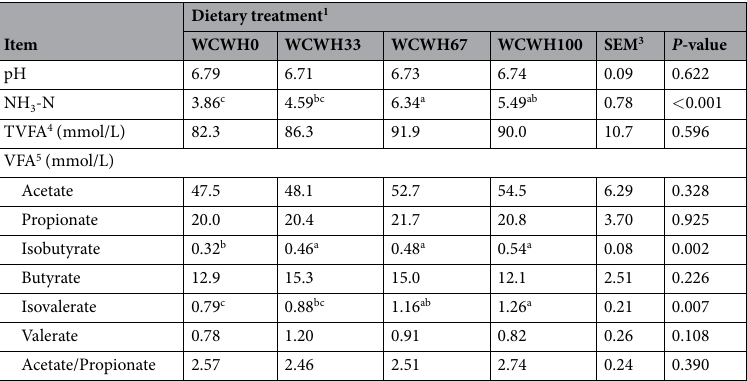
Table 3. The effects of dietary treatments on rumen fermentation of Holstein dairy bulls during the fattening period 1,2 . 1 WCWH0 = 0% of Leymus chinensis was replaced by whole-crop wheat hay; WCWH33 = 33% of Leymus chinensis was replaced by whole-crop wheat hay; WCWH67 = 67% of Leymus chinensis was replaced by whole-crop wheat hay; WCWH100 = 100% of Leymus chinensis was replaced by whole-crop wheat hay. 2 a–c: Means within the same row without the same letter superscripts are significantly different (Tukey’s test; P < 0.05). 3 SEM: Standard error of the mean. 4 Totalvolatile fatty acids. 5 Volatile fatty